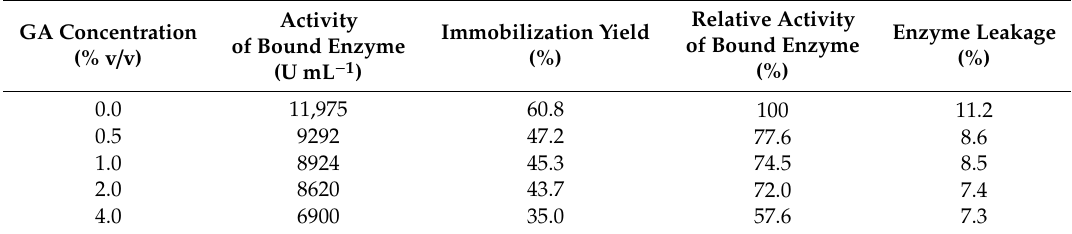
Table4. E ff ectoftheconcentrationofglutaraldehyde(GA)oninvertaseimmobilizationinalginate-based hydrogel (cross-linking time 10